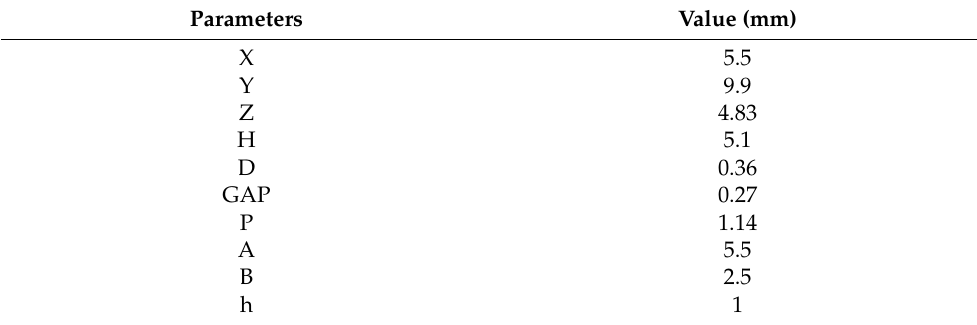
Table 4. Optimized design parameters (input/ output cavities).